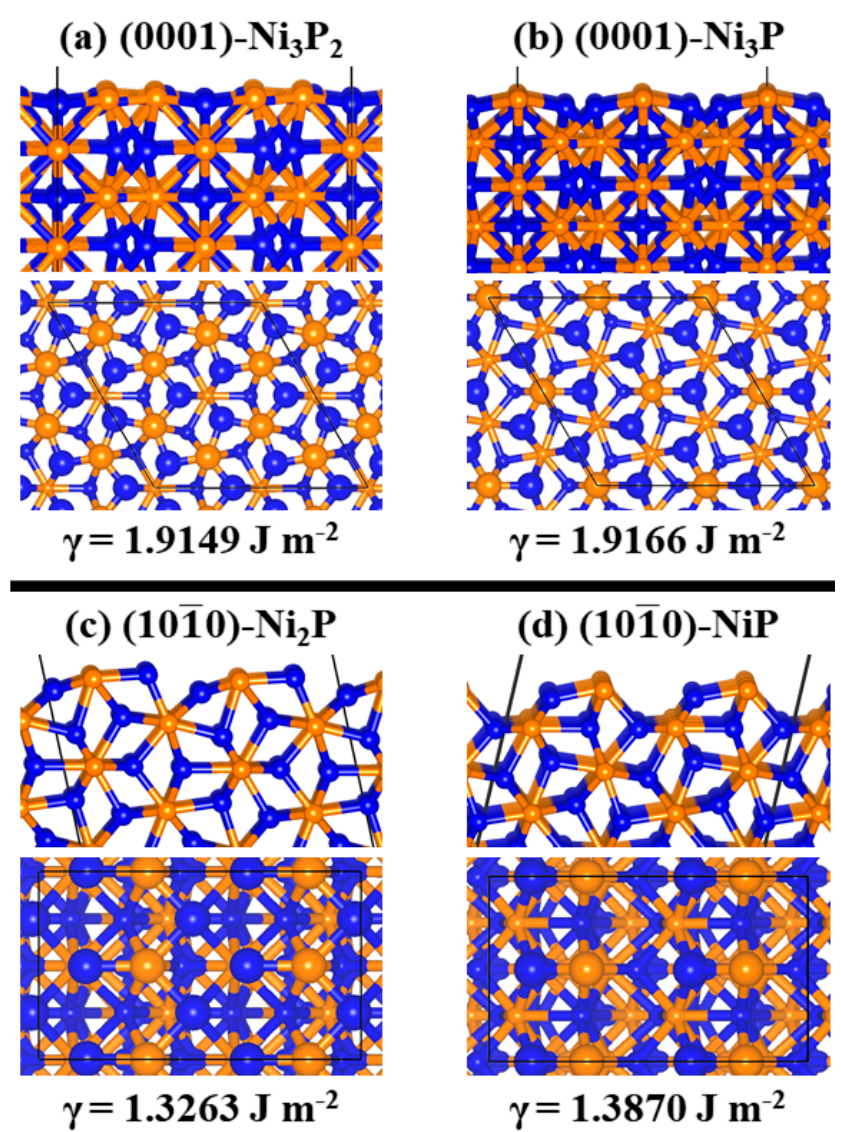
Figure 2. Schematic illustration of the side (top row) and top (bottom row) views of the relaxed structures of the ( a ) Ni 3 P 2 - and ( b ) Ni 3 P-terminations of (0001) surface, ( c ) Ni 2 P- and ( d ) NiP-terminations of (10 1(cid:3364) 0) surface. γ denotes the surface energy.